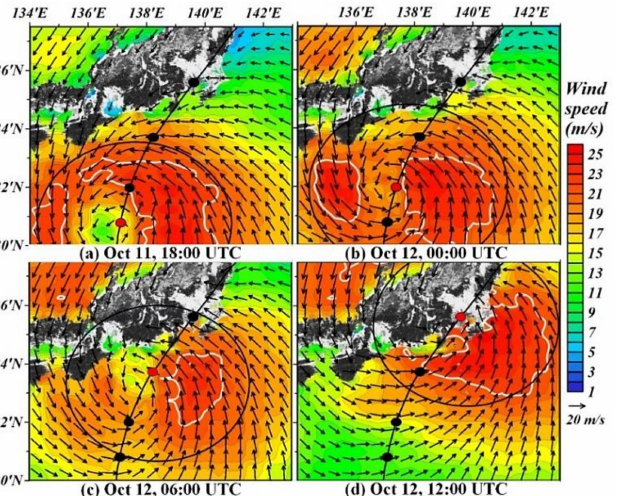
Figure 3. Validation of each six-hourly storm wind zone of HAGIBIS between JMA (black circles) and CMEMS data (white contours) with the typhoon central location according to time; ( a ) 11 October, 18UTC, ( b ) 12 October, 00UTC, ( c ) 06UTC, and ( d ) 12UTC,